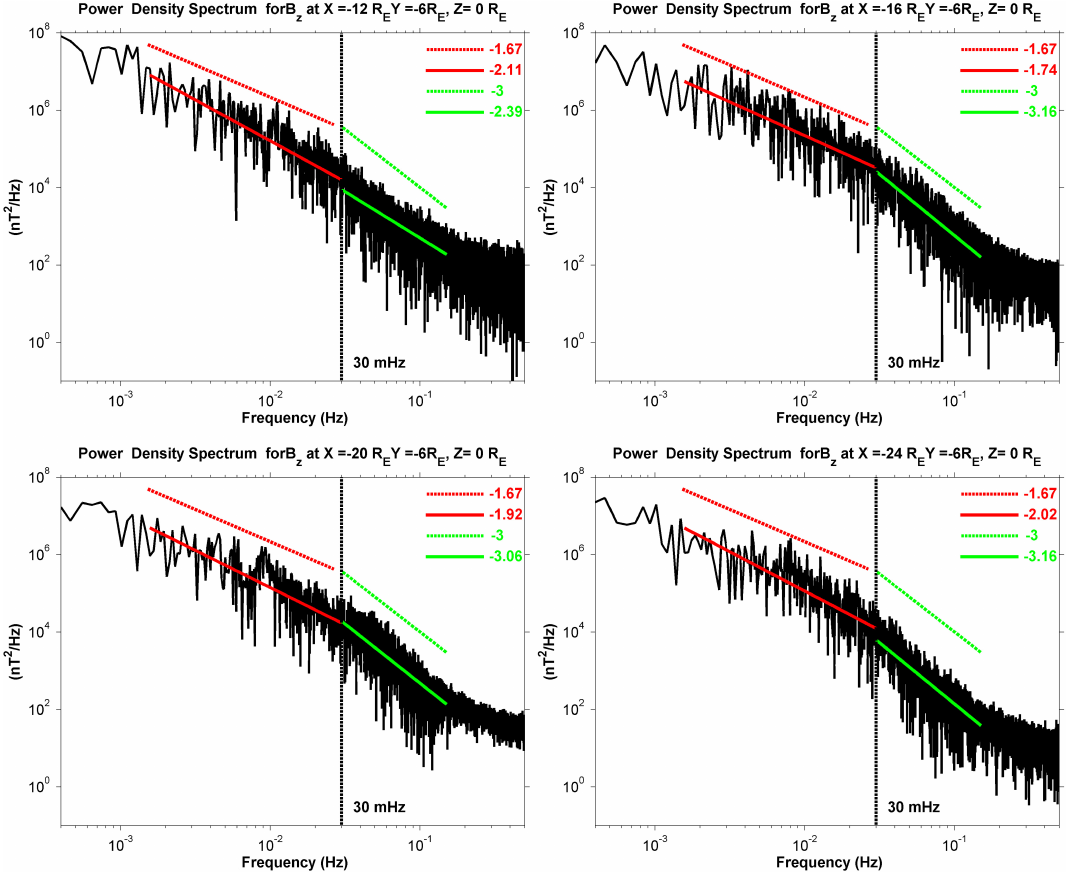
Fig. 3. The panels show power spectra for B z at four locations. The solid red (green) lines are least squares fits in the inertial (dissipative) range. The dotted red (green) lines, shown for comparison, have the slopes of the theoretical predictions in the inertial (dissipative) ranges. In the x-direction the minimum grid spacing was 0.11 R